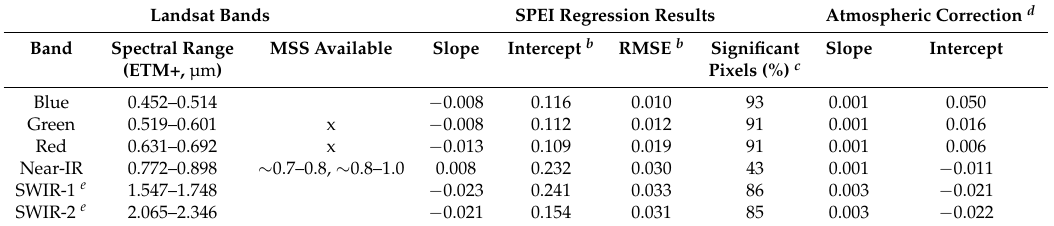
Figure 5. Example pixel fits of SPEI versus red Landsat reflectance for observations during Day of Year 180–220 ( ∼ July). All four example pixels are from unmixed areas classified as grassland throughout the study period. Table 3. Description of Landsat bands and mean results of regression with SPEI a